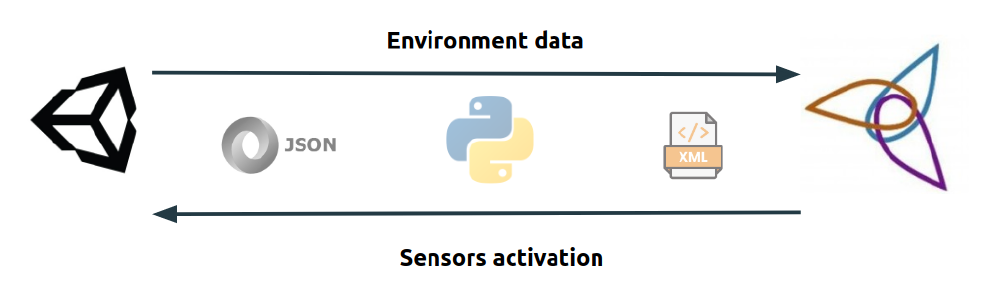
Figure 6. Illustration of the technical implementation.